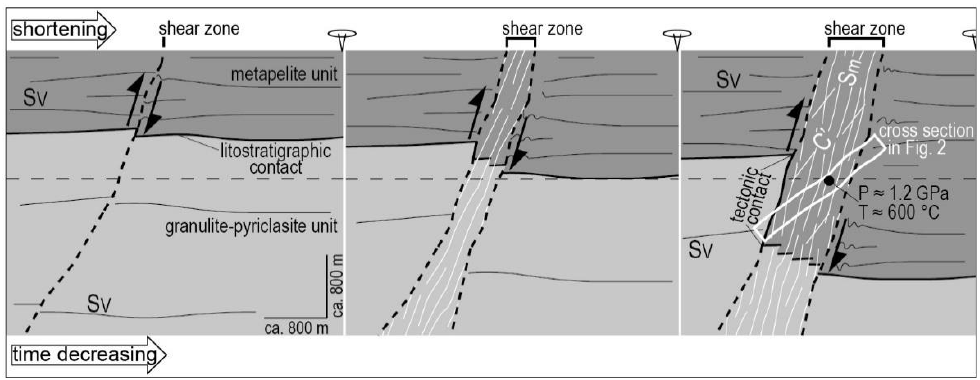
Figure 7. Synoptic sketch showing the evolution of the (eo-)Alpine shear zone of the Serre dei Meriani-Passo Fosso del Lupo area, before the occurrence of crustal tilting that began in the late Oligocene. Note the nucleation of the future shear zone as reverse fault (left), ductile widening with time (centre to right) and P – T equilibration only in the shear zone (right).